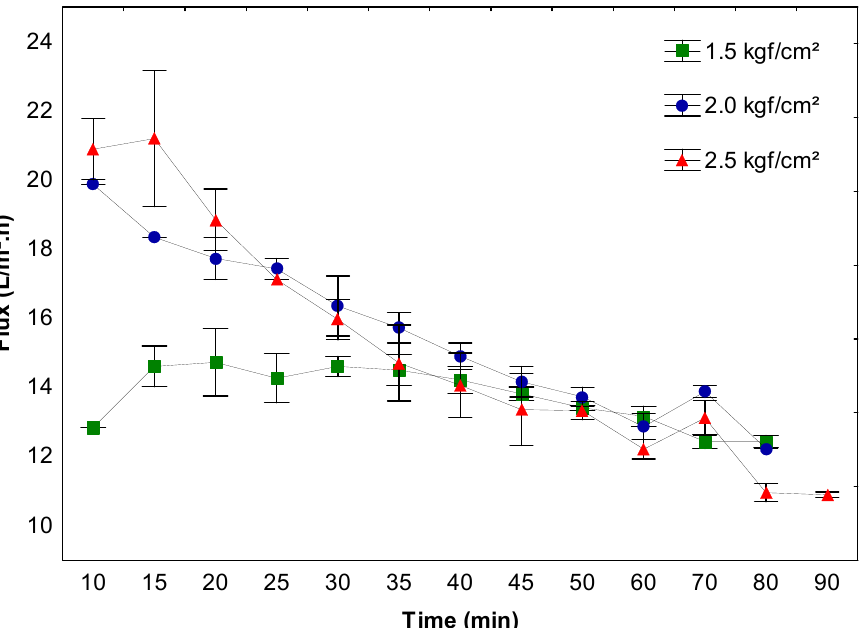
Figure 3. Permeate flux and effect on the enzyme concentration using a 50 kDa membrane at pH 7.5 and 1.5, 2.0, and 2.5 kgf/cm 2 operating pressures.